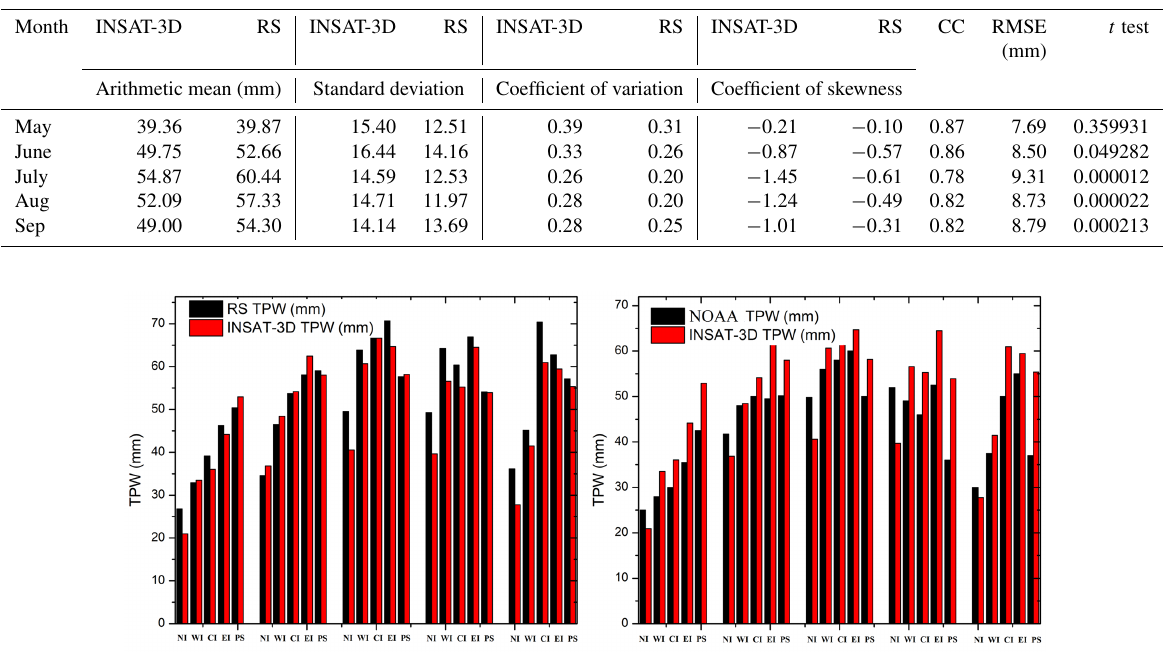
Figure 5. Comparison of INSAT-3D-derived TPW with RS- and NOAA-observed TPW at subdivision scales NI, WI, CI, WI, and PS from May to September